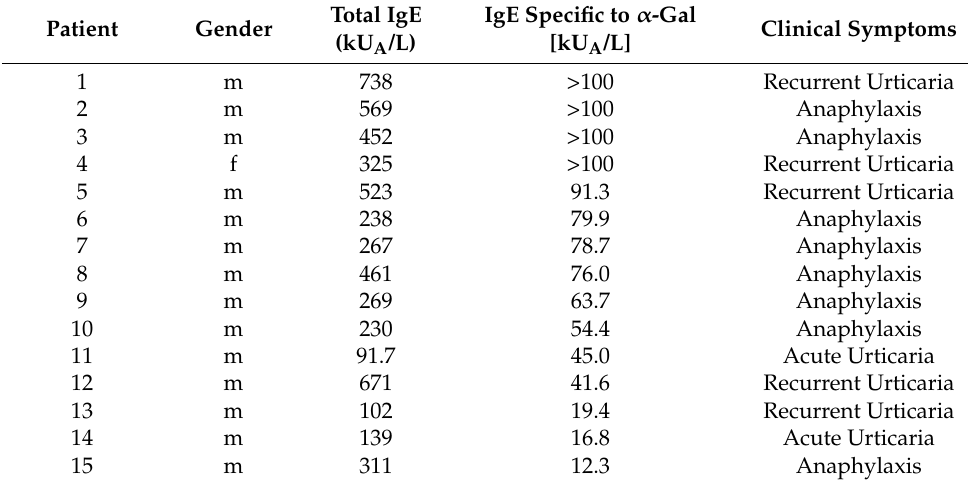
Table 1. Clinical data on the